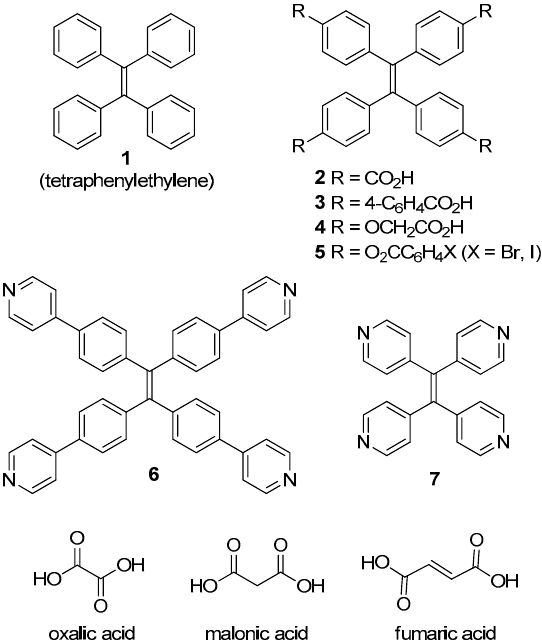
Figure 1. Tetraphenylethylene ( 1 ) and tetraarylethylene derivatives ( 2 – 6 ) with proven utility as crystal engineering building blocks. Described below are the structures of three salts and co-crystals assembled from 7 and oxalic acid, malonic acid, and fumaric acid.